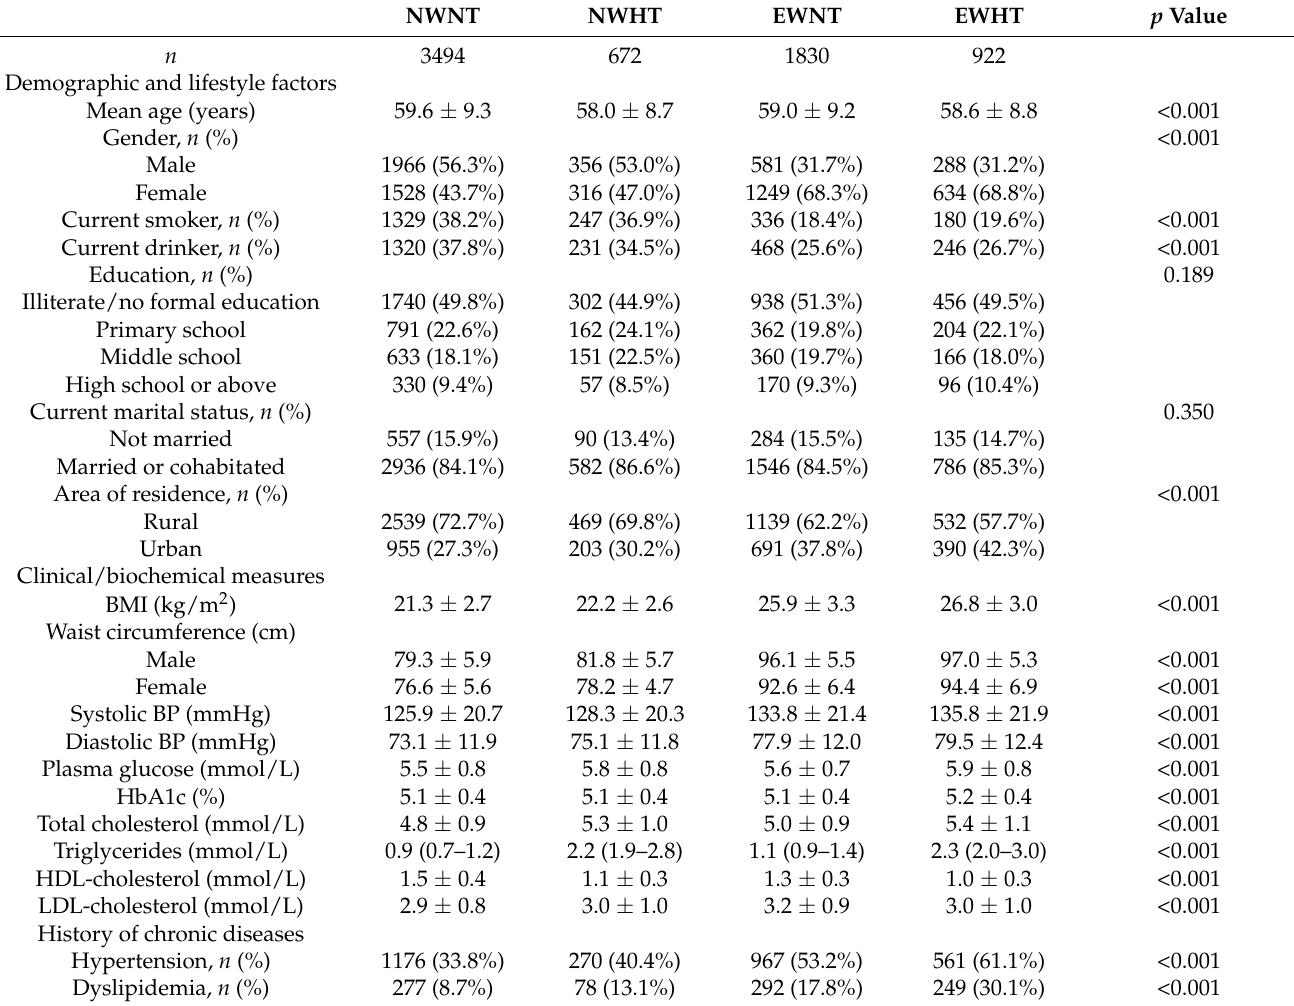
Table 1. Comparisonofbaselinedemographic,